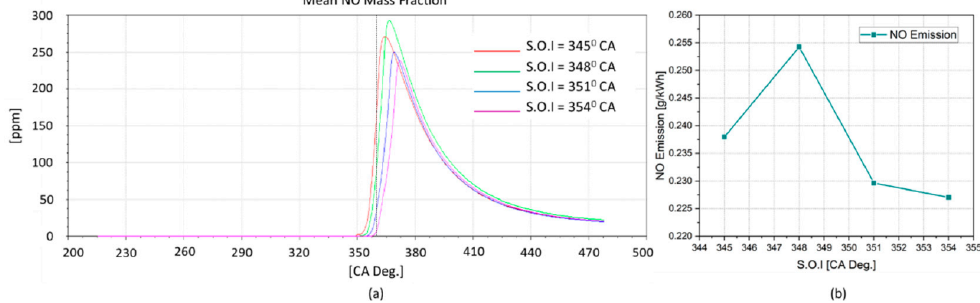
Figure 24. Mean NO mass fraction diagrams ( a ) and NO emission masses ( b ) according to the change of the pilot S.O.I angle in the dual-fuel mode.